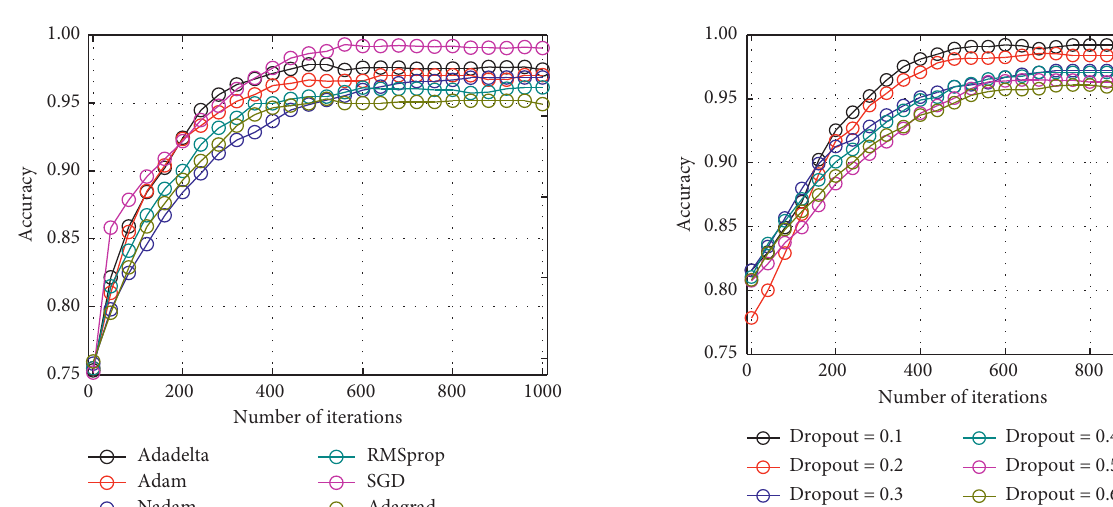
Figure 11: Comparison of recognition accuracy of six training methods.